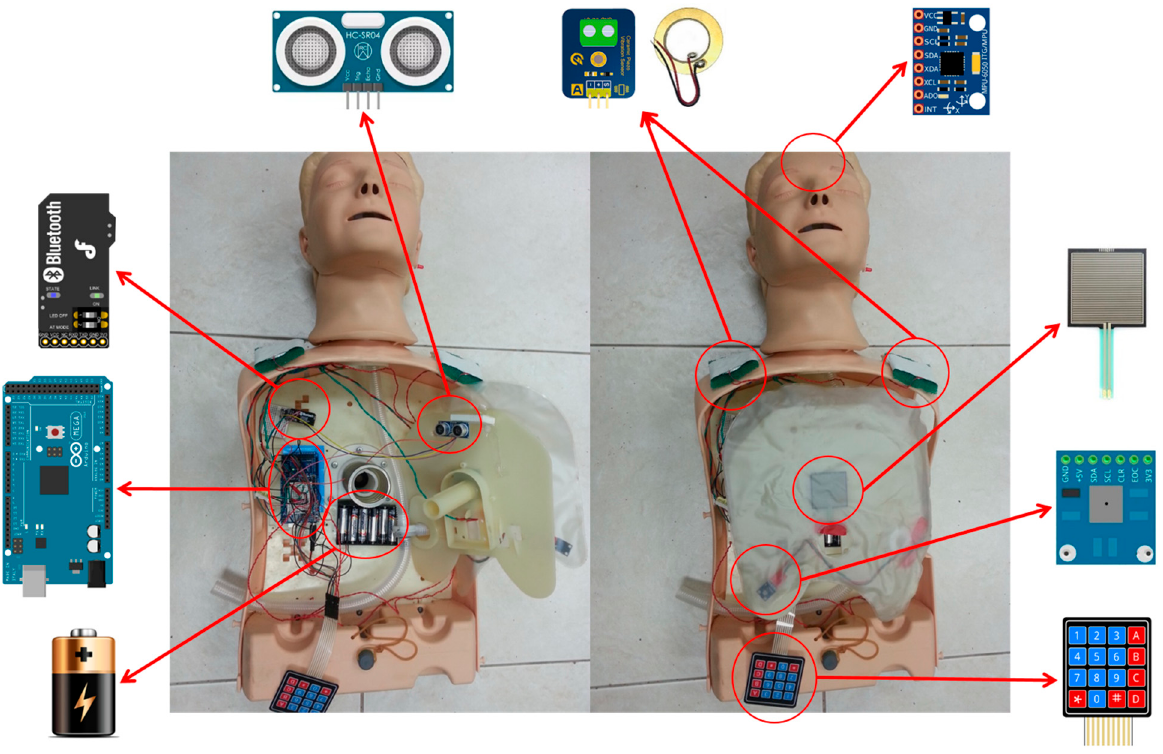
Figure 18. The sensors installed inside the CPR manikin.